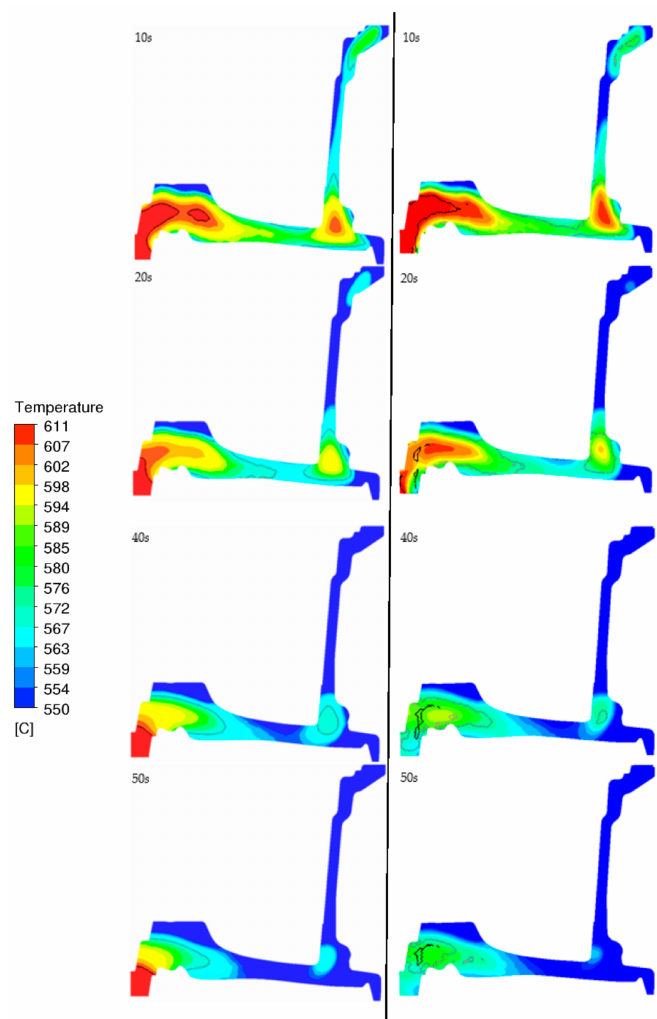
Figure 9. Solidification sequence in the wheel from thermal-only simulation ( left ) and fully coupled model ( right